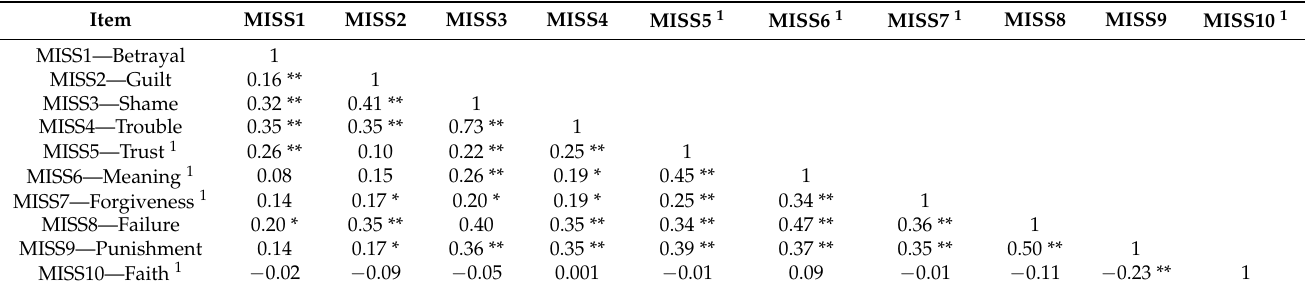
Table 3. G-MISS-HP interitem correlation matrix (Pearson’s correlation coefficients). Item